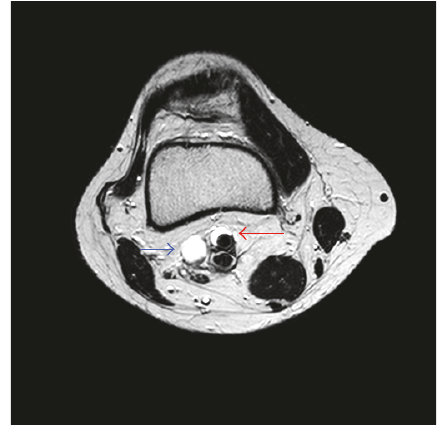
Figure 2: Magnetic resonance imaging (T2-weighted images) revealed cystic lesion encompassing the right popliteal artery cir- cumferentially. Red arrow: cystic adventitial disease of popliteal artery. Blue arrow: venous aneurysm of popliteal vein (it was not diagnosed preoperatively).